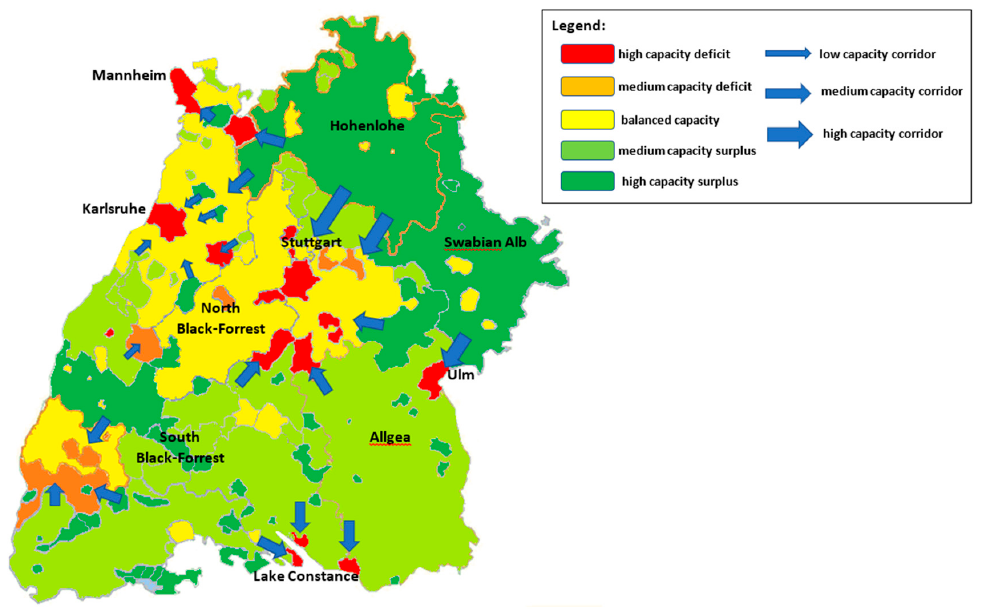
Figure 6. Scenario 2050 for diminishing consumption and increasing regenerative energy supply.